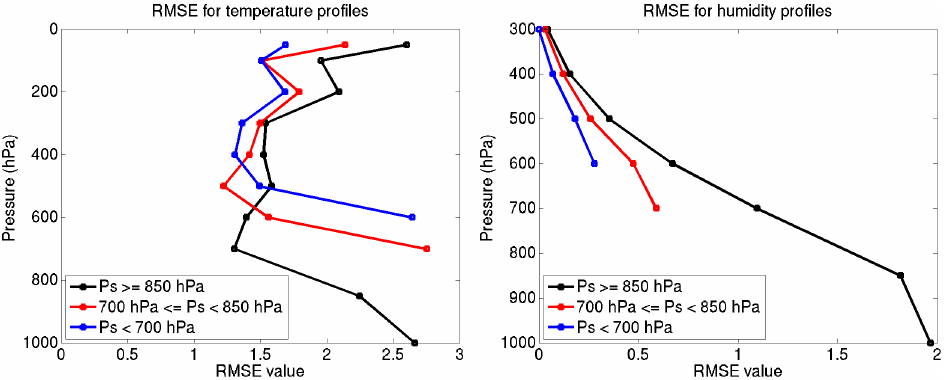
Figure 3. Using a set of data that consist of simulated HIRS channel brightness temperatures by RTTOV with ECMWF profile input that are not used in the retrieval scheme development, retrieval performances for upper air profiles over different surface elevations (represented by surface pressures) are examined. The RMSEs are shown in the figure for temperature (in °C, left panel ) and specific humidity (in g/kg, right panel ).